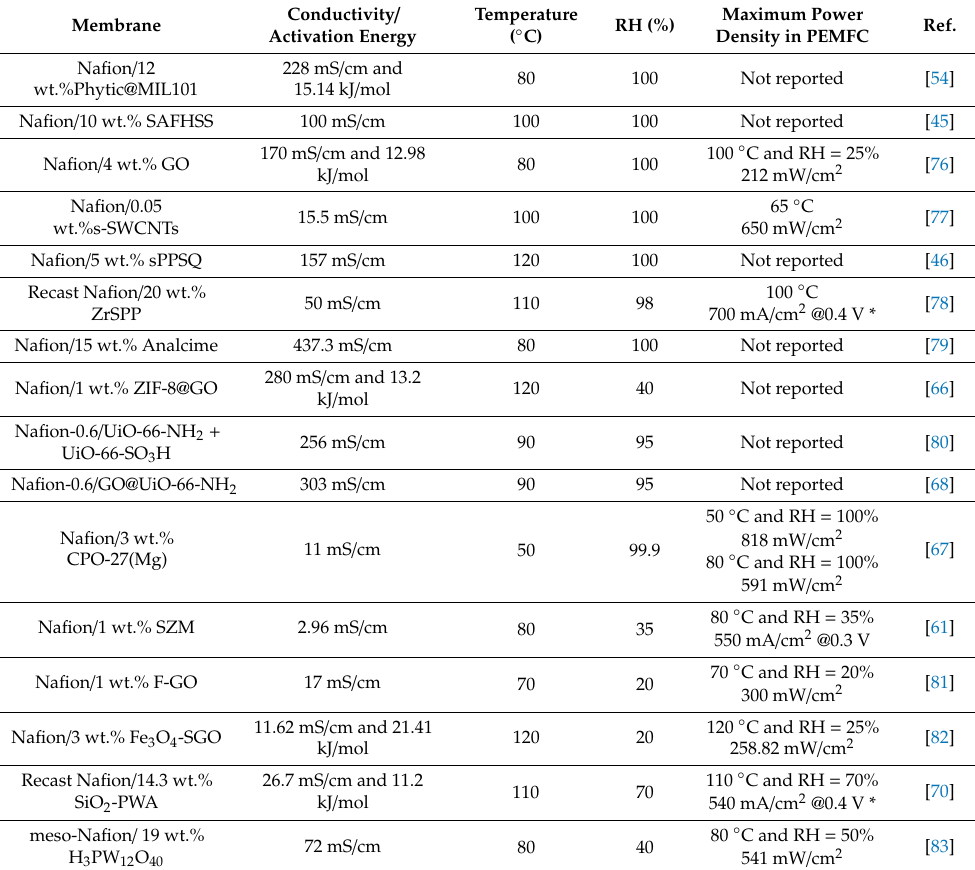
Table 2. Comparison of proton conductivities of Nafion-based composite membranes and their PEMFC